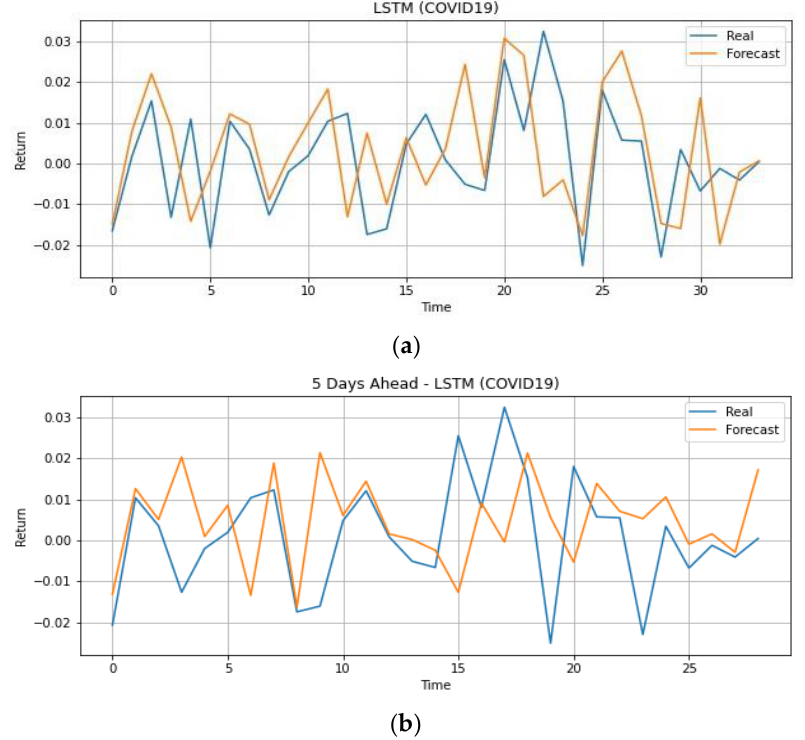
Figure 15. LSTM COVID-19 Forecasting Result After COVID-19 Pandemic with One-Day- ( a ) and Five-Day-Ahead ( b ) Forecast.